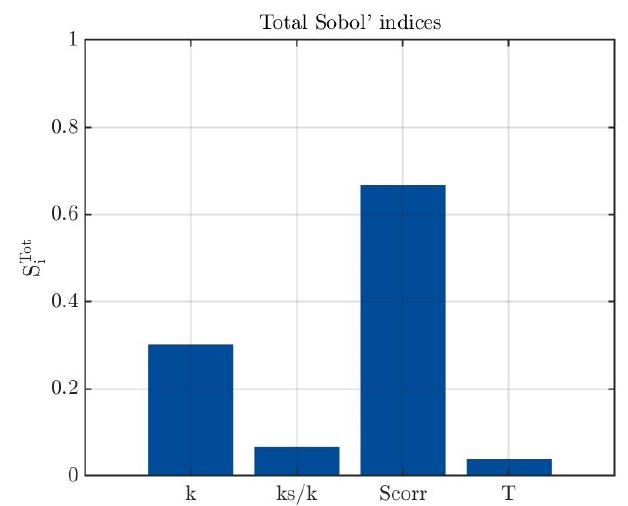
Figure 12. Total Sobol indexes for metamodel M 2 T and the HAX thermal correction model.